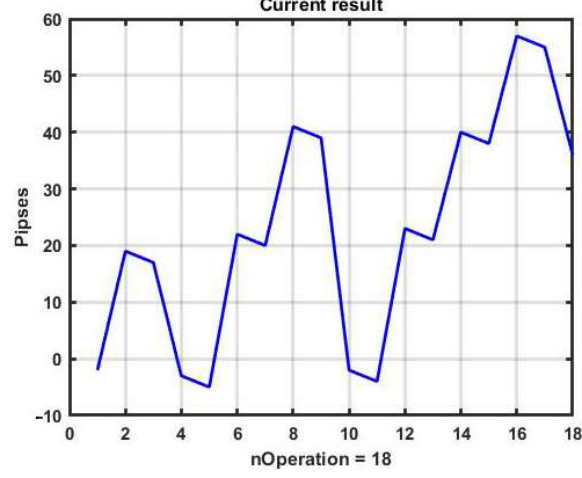
Figure 4. Performance in the case of using CSF in example 2.